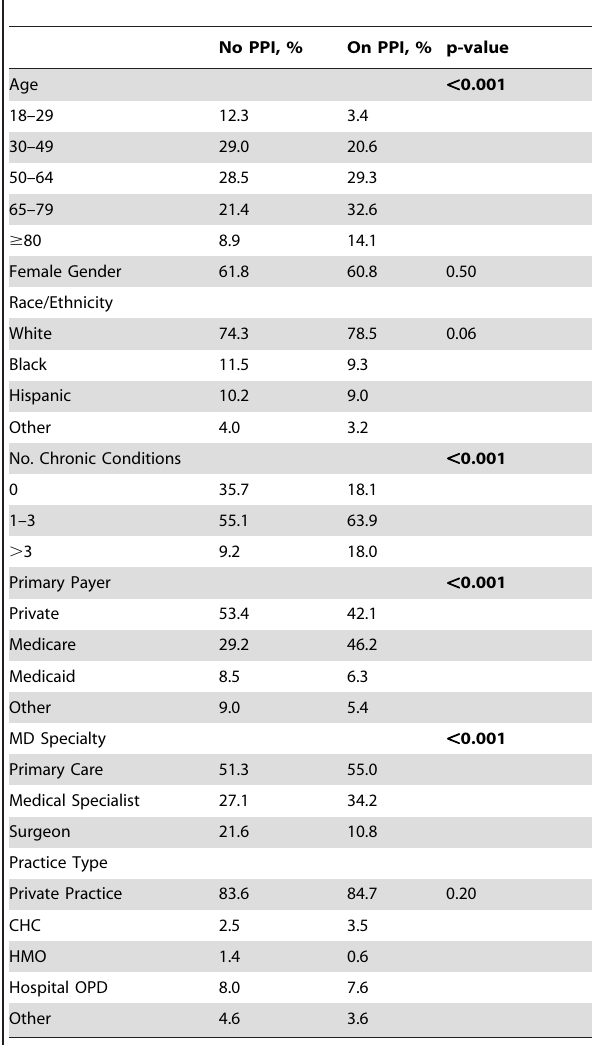
Table 3. Characteristics of visits by patients on PPIs, 2008– 2009 a